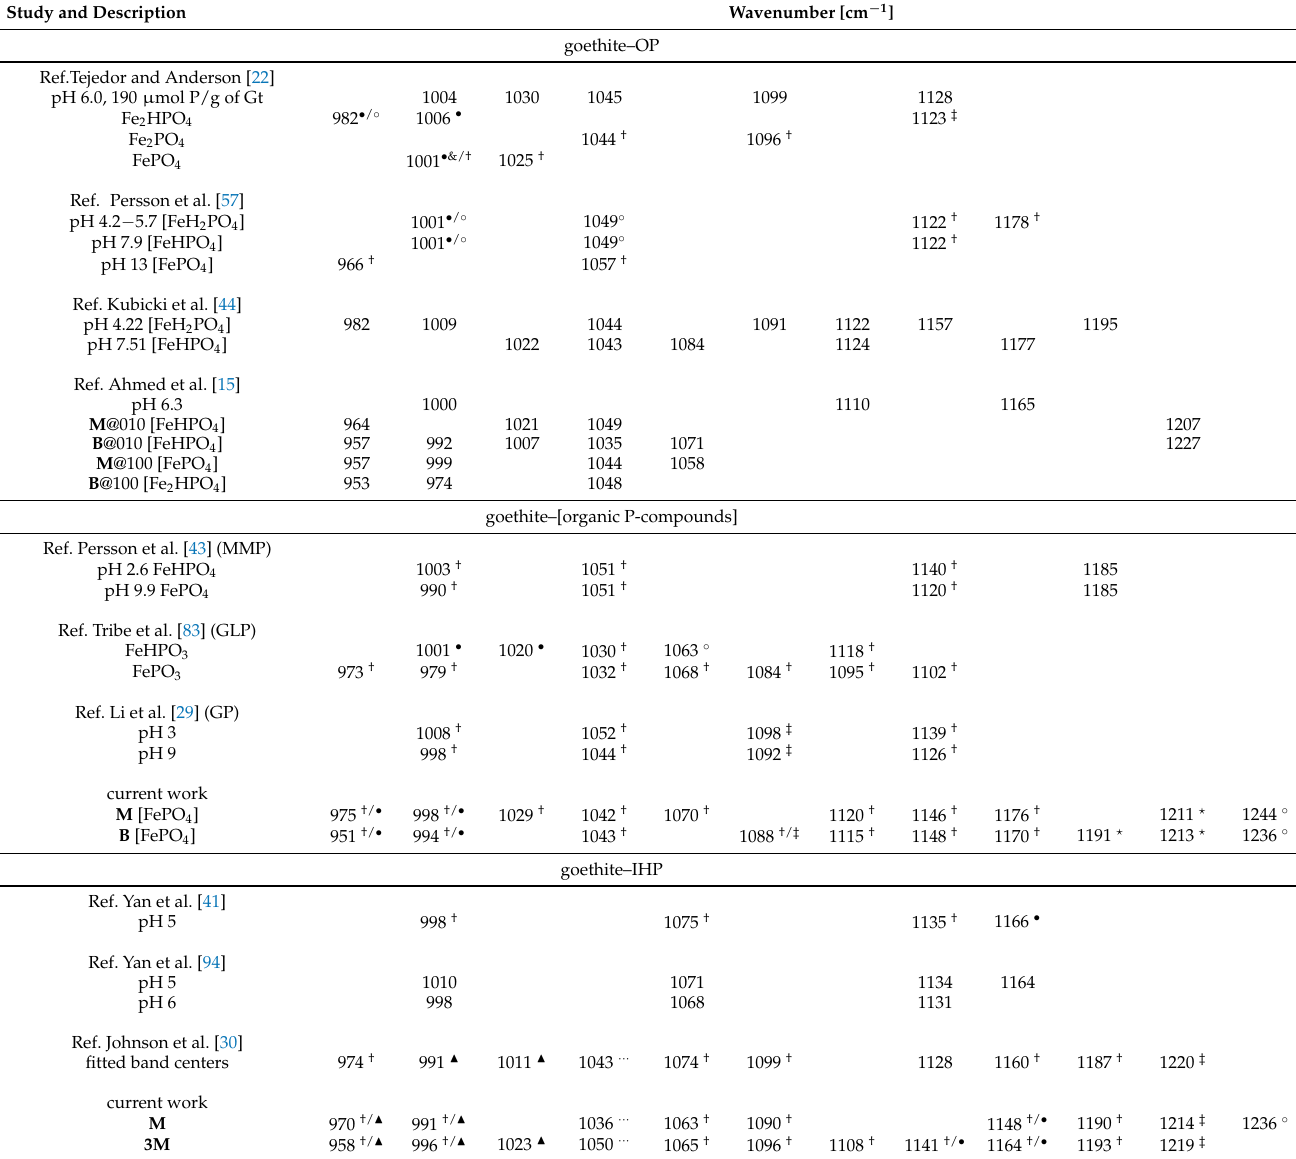
Table 1. Experimental and theoretical IR frequencies from selected studies related to phosphates OP, GP, IHP, and others on goethite are listed below. The IR frequencies calculated here for GP and IHP on goethite are also presented here. The symbols †, ‡, • , ◦ , (cid:78) , · · · , and (cid:63) denote [P–O], [P = O], [P–OFe], [P–OH], [P–O–C], [P–O · · · H], and [C–C–C] plus [C–O–C] modes, respectively. The symbols are assigned to frequencies only when specifically mentioned in reference experimental study. The frequency assigned to multiple modes is denoted as • / ◦ represent [P–OFe] or [P–OH] modes while • &/ ◦ represent [P–OFe] and/or [P–OH]